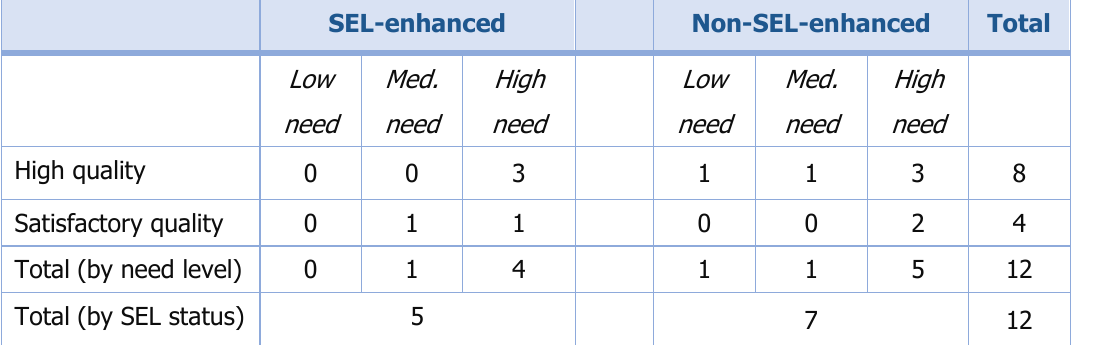
Table 2. Analysis 2: Number of OST Programs by Quality Level, SEL Enhancement Status and Community Socioeconomic Need